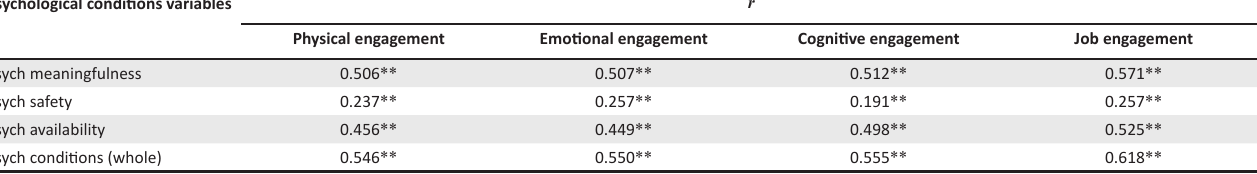
TABLE 3 : Pearson correlation coefficients ( r ) for relations of psychological conditions and job engagement. Psychological conditions variables